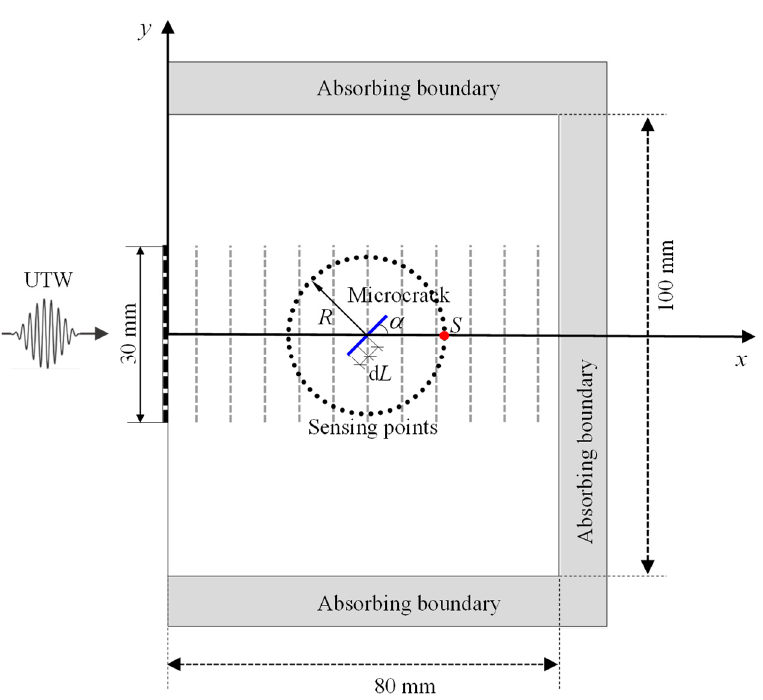
Figure 2. A 2D model of nonlinear interaction between an incident ultrasonic transverse wave (UTW) and a microcrack.